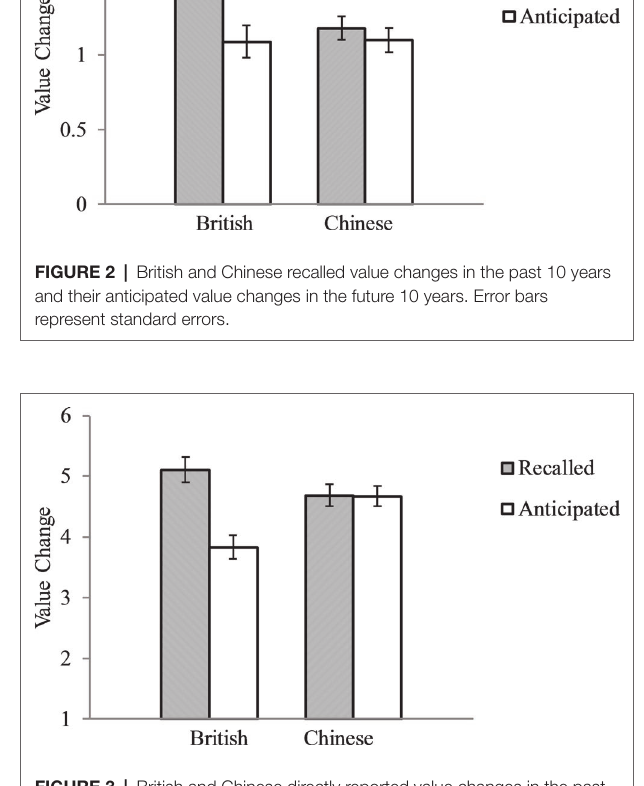
FIGURE 3 | British and Chinese directly reported value changes in the past 10 years and in the future 10 years. Error bars represent standard